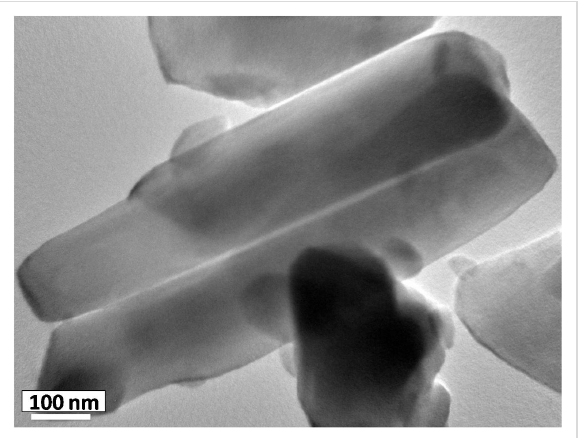
Figure 5: TEM micrograph of the one-dimensional structure of h-MoO 3 .